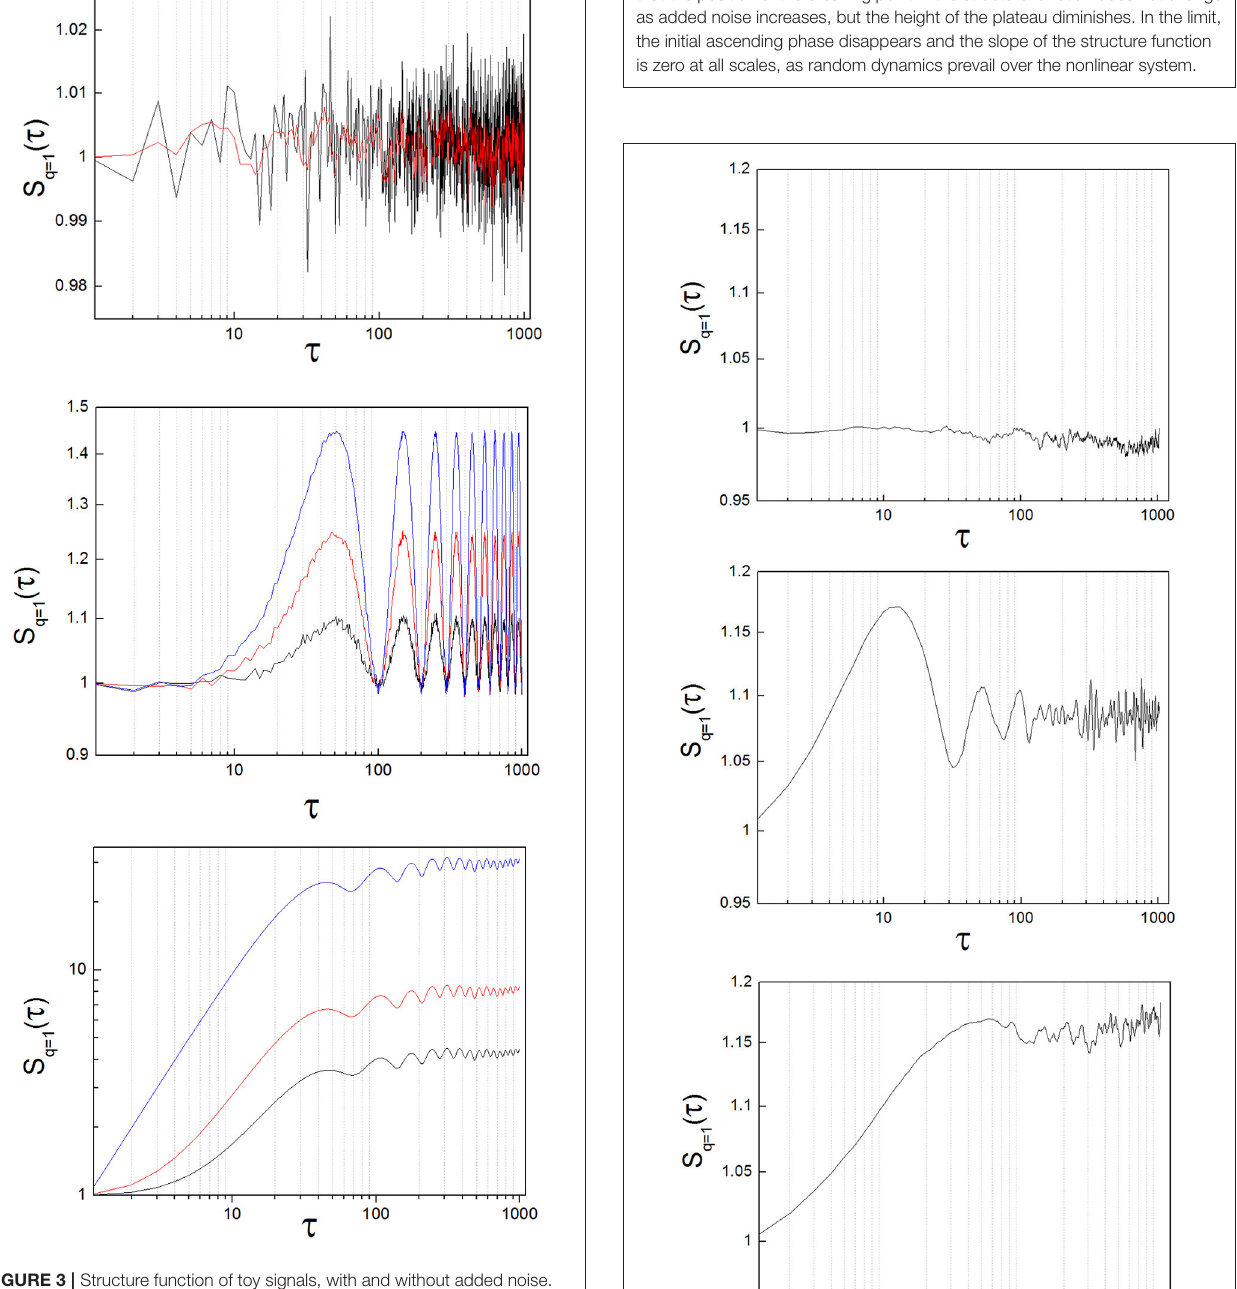
Frontiers in Human Neuroscience |